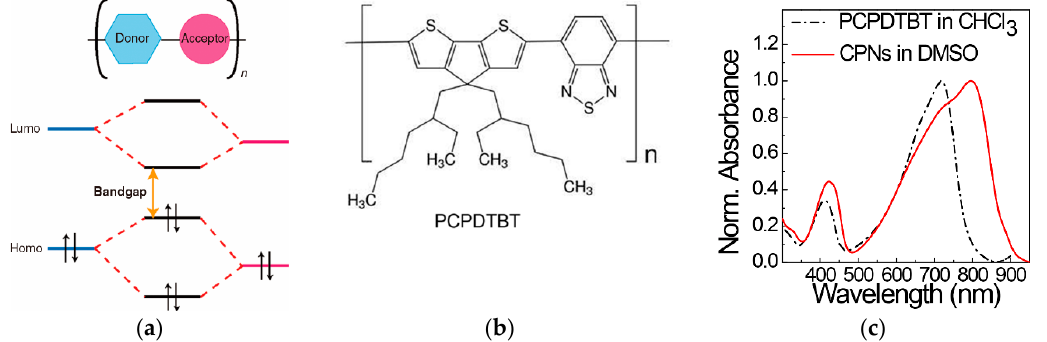
Figure 4. ( a ) Simplified electronic structure of donor-acceptor copolymer chains with a low bandgap. Reproduced from Ref. [95] with permission. Copyright 2017 John Wiley and Sons, ( b ) chemical structure of PCPDTBT and ( c ) its absorption spectra in chloroform solution and CPNs. Reproduced from Ref. [102].